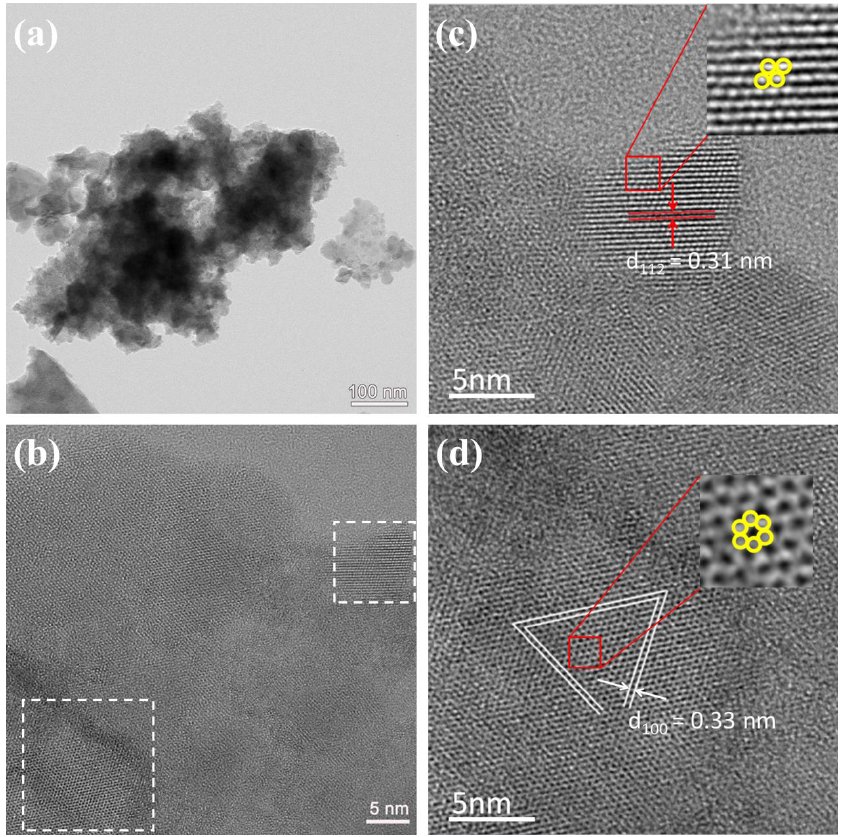
Figure 3. ( a ) TEM and ( b ) HRTEM image of CZTS-24 h sample, ( c ) and ( d ) the magnified images of two regions marked with white rectangles in ( b ).